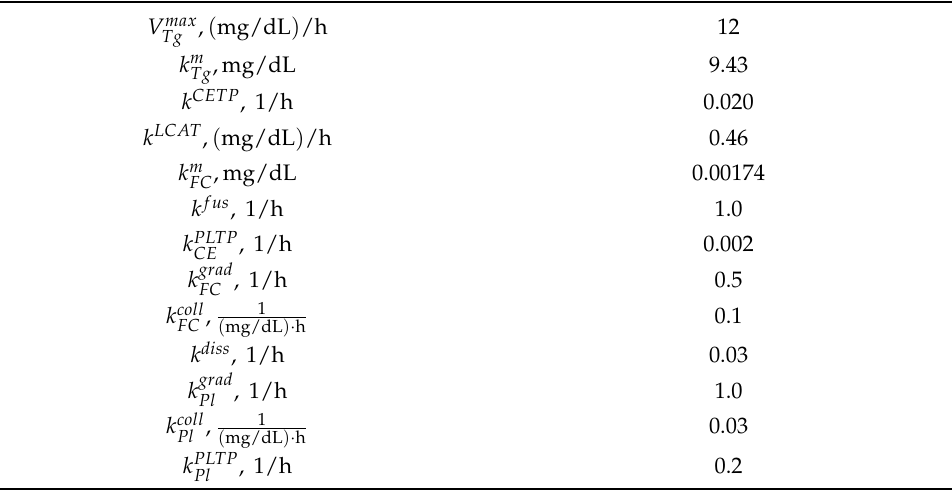
Table 6. The values of the rate constants used in the